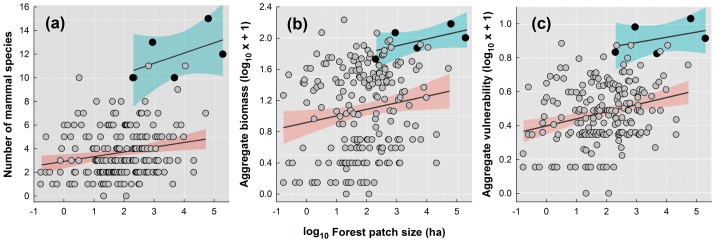
Species-area relationships (SARs) for (a) species richness, (b) a measure of total biomass, and (c) a measure of total species vulnerability for 18 mammal species surveyed at 196 forest patches of the Atlantic forest of northeastern Brazil.Solid circles (and corresponding regression lines and 95% confidence intervals) indicate the five existing strictly protected forest areas in the entire study region, for which intercepts were clearly higher. All other data points (gray circles) represent unprotected forest sites.